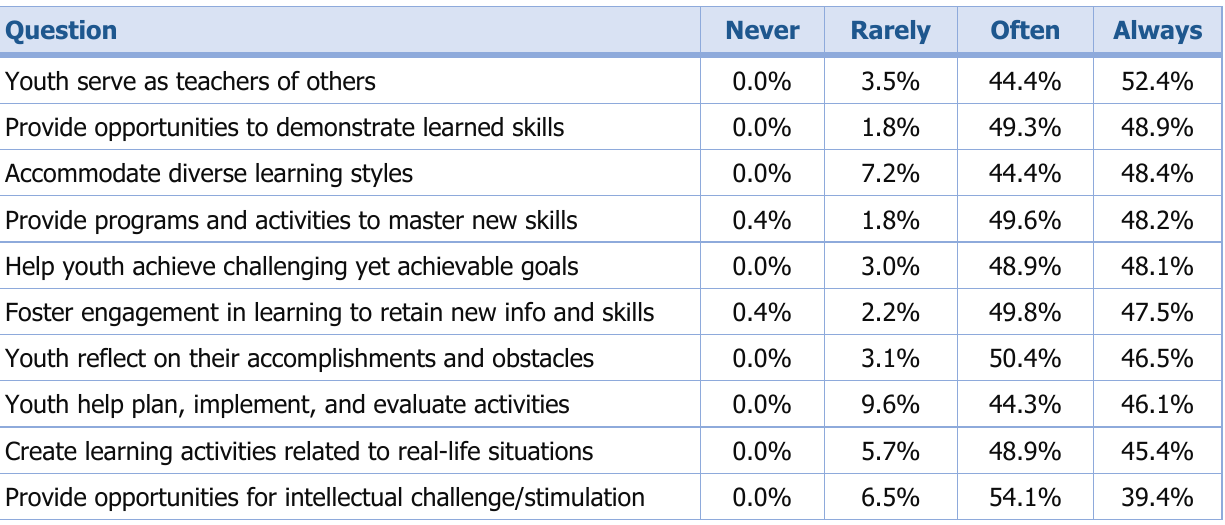
Table 3. Frequency of Volunteer Responses to Questions on Practices That